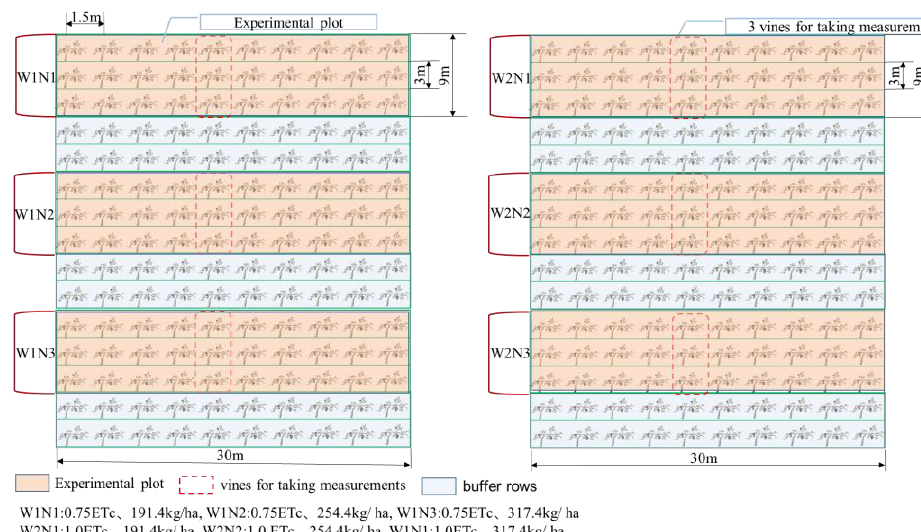
Figure 3. Diagram of experimental treatment.